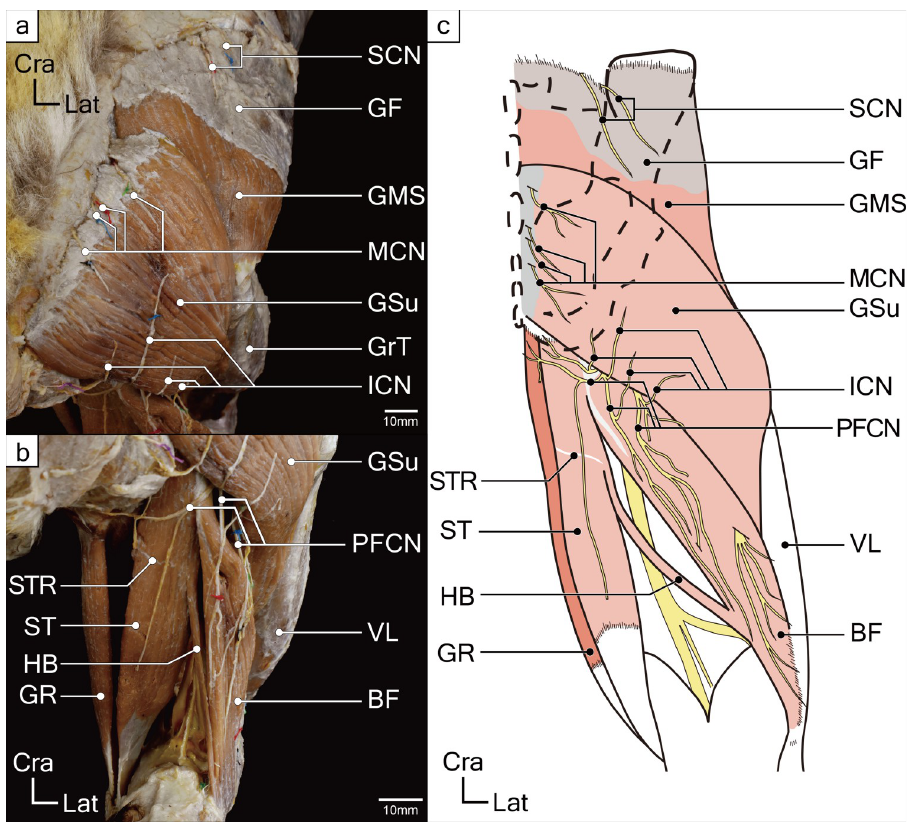
Fig 1. Superficial layer muscles of gluteal and posterior femoral regions in a koala right hind limb. ( a ) The superficial gluteal muscles, the gluteus superficialis (GSu) and superficial part of the gluteus medius (GMS), and some cutaneous nerves are shown. ( b ) The thigh flexors and some cutaneous nerves are shown. ( c ) Illustrated schematic drawing of the superficial layer muscles of gluteal and posterior femoral regions. Abbreviations: BF, biceps femoris; GF, gluteal fascia; GMS, superficial layer of the gluteus medius; GR, gracilis; GrT, greater trochanter; GSu, gluteus superficialis; HB, hamstring bundle; ICN, inferior cluneal nerve; MCN, middle cluneal nerve; PFCN, posterior femoral cutaneous nerve; SCN, superior cluneal nerve; ST, semitendinosus; STR, semitendinosus raphe; VL, vastus